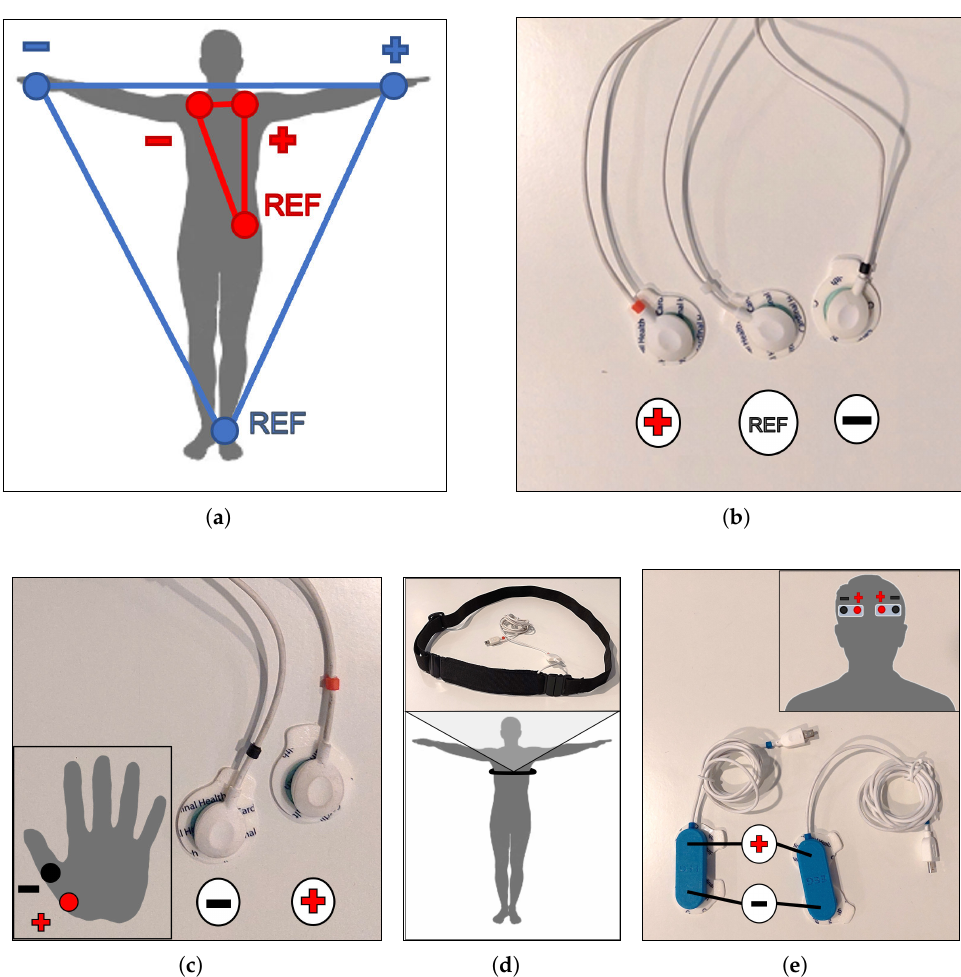
Figure 5. Sensor placement: ( a ) lead I Einthoven configuration; ( b ) ECG electrodes; ( c ) EDA electrodes and their placement on the palm; ( d ) PZT chest-band and its location around the chest; ( e ) EEG electrodes and their location on the